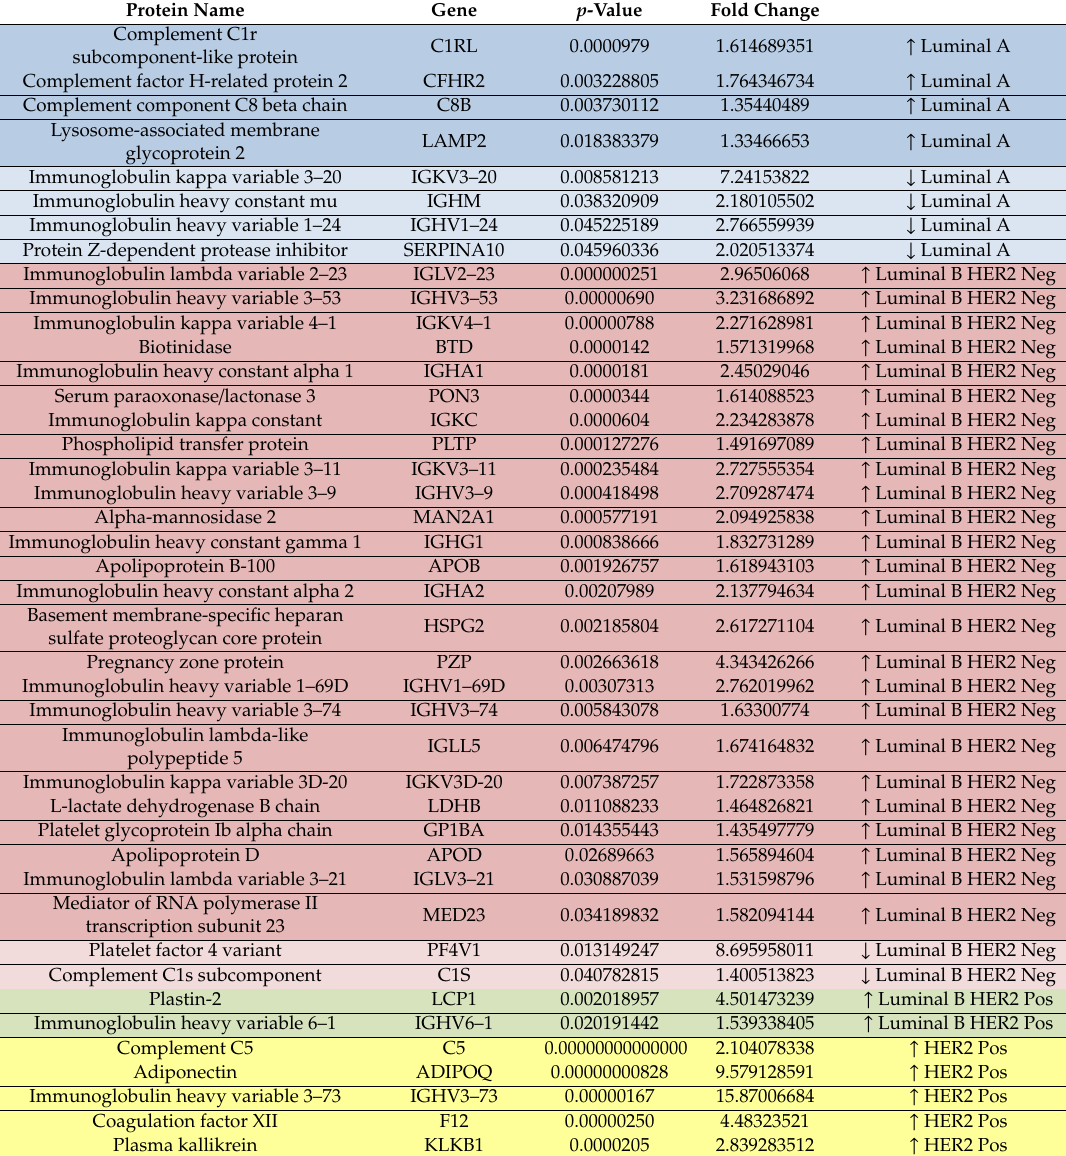
Table 2. Di ff erentially expressed proteins (up- and downregulated) ( p -value ≤ 0.05) found in the protein patterns of the ex vivo formed coronas after the analysis by SWATH-MS specific (or unique) for the di ff erent breast cancer subtypes (LA, LB-, LB + , HER2 + and TNBC) in comparison with healthy control (HC) samples. The fold change ratio was calculated as the ratio of geometric means of the sample replicates, which corresponds to calculating the normal arithmetic ratio of log-transformed areas and